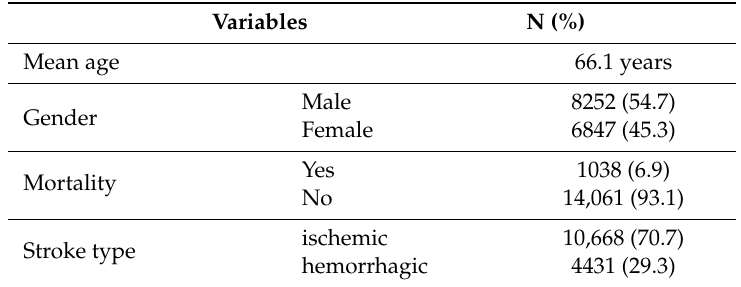
Figure 1. The patient selection process. KNHDS = Korean National Hospital Discharge In-depth Injury Survey. ICD = International Classification of Diseases. Table 1. Distribution of subjects by general characteristics.